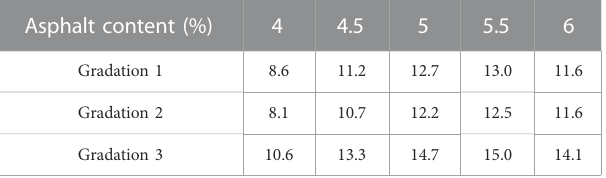
TABLE 13 K values for different asphalt contents. Asphalt content (%)